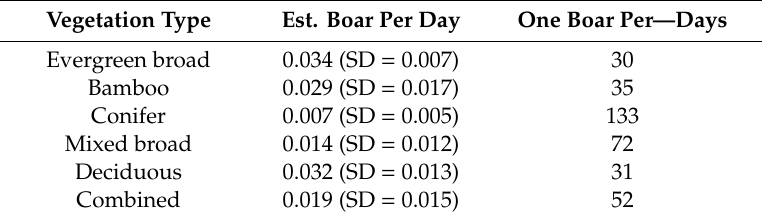
Table 2. Mean estimated boar density by vegetation type.